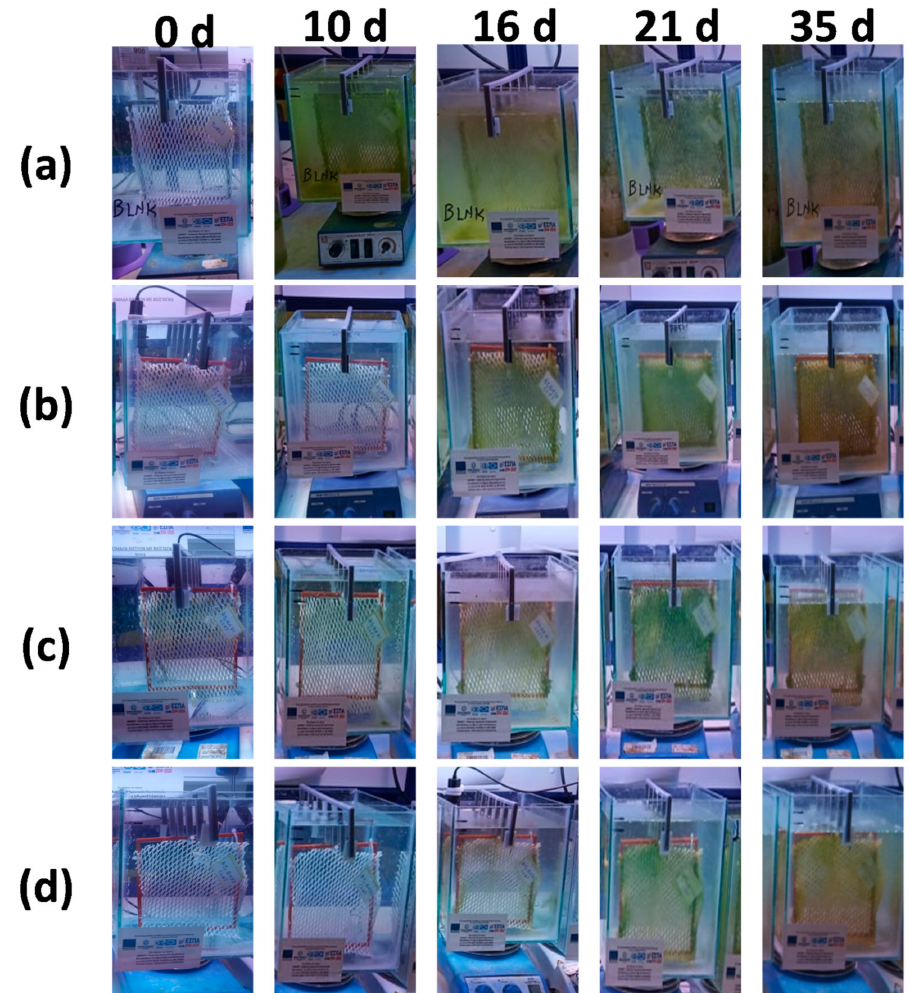
Figure 4. Photographs of the uncoated ( a ) and the coated ( b – d ) nets at the beginning of the immersion (t = 0 d) and after 10 d, 16 d, 21 d, and 35 d of